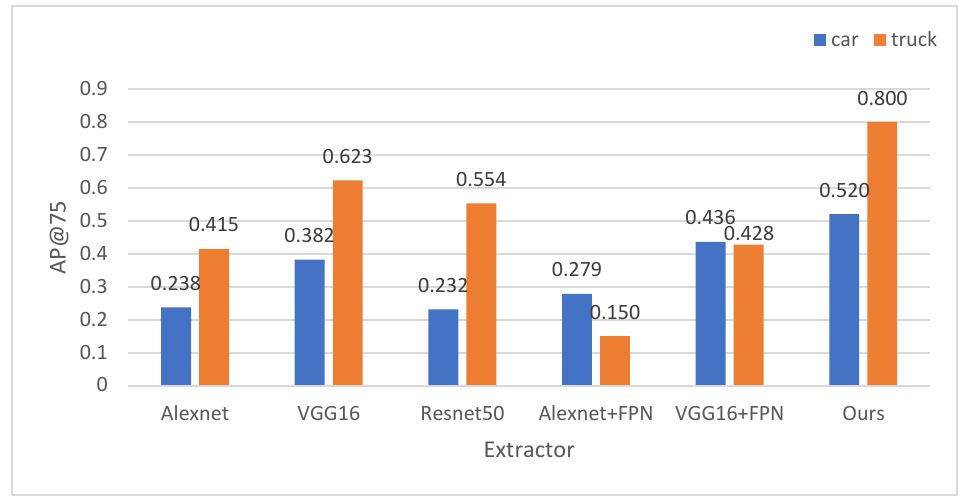
Figure 16. The comparison results of the proposed detection method with Faster-RCNN using other extractors on AP@75.